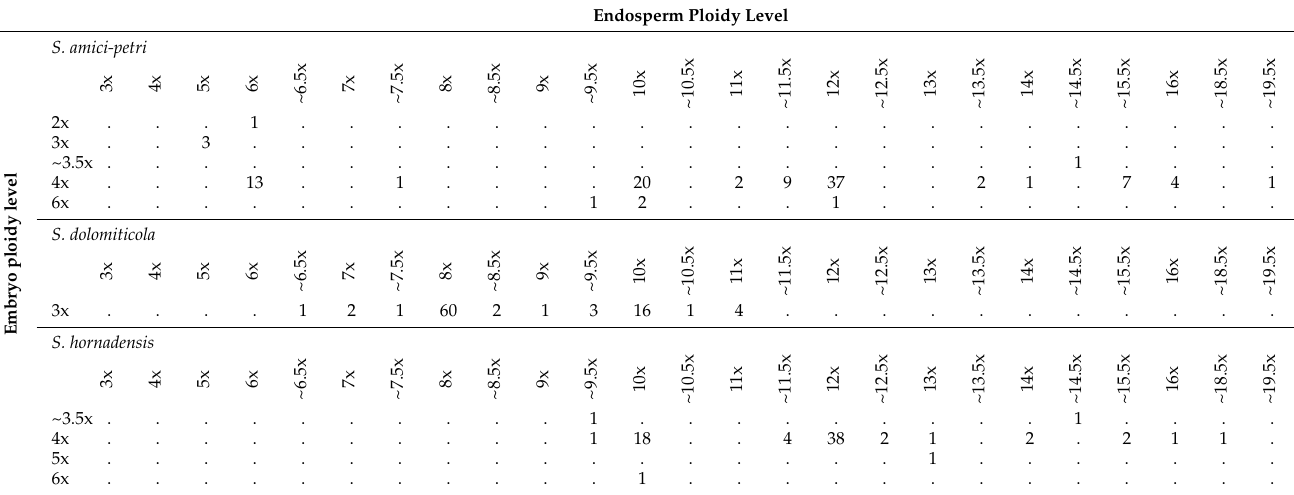
Table 1. Frequency of seed categories in Sorbus amici-petri , S. dolomiticola , and S. hornadensis . Embryo ploidy levels are listed in rows and endosperm ploidy levels are listed in